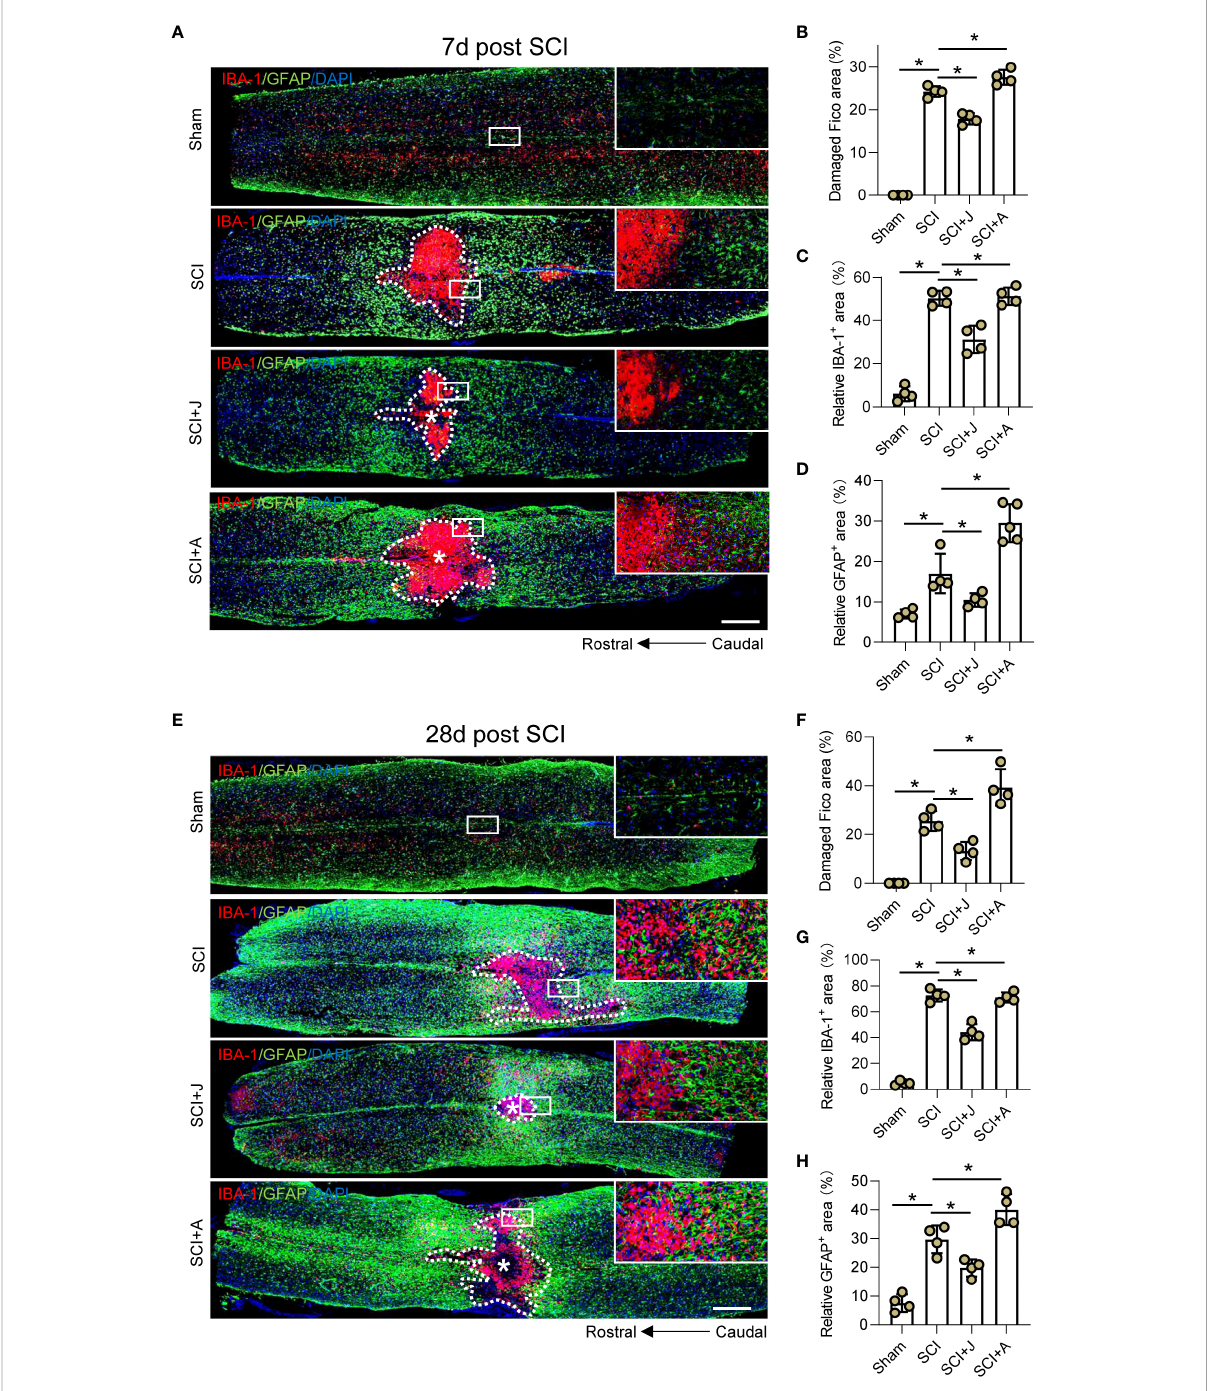
FIGURE 6 CB2R mitigated expansion of neuronal damage and formation of glial scarring post-SCI. (A) IF staining of GFAP (green) and IBA-1 (red) on day 7 post-SCI. Scale bar = 500 m m. Quantitative analysis of the area of injured foci inside the white dotted line (B) , microglia-occupied area, (C) and astrocyte-occupied area (D) on day 7 post-SCI. (E) IF staining of GFAP (green) and IBA-1 (red) on day 28 post-SCI. Scale bar = 500 m m. Quantitative analysis of the area of injured foci inside the white dotted line (F) , microglia-occupied area, (G) and astrocyte-occupied area (H) on day 28 post-SCI. * p <